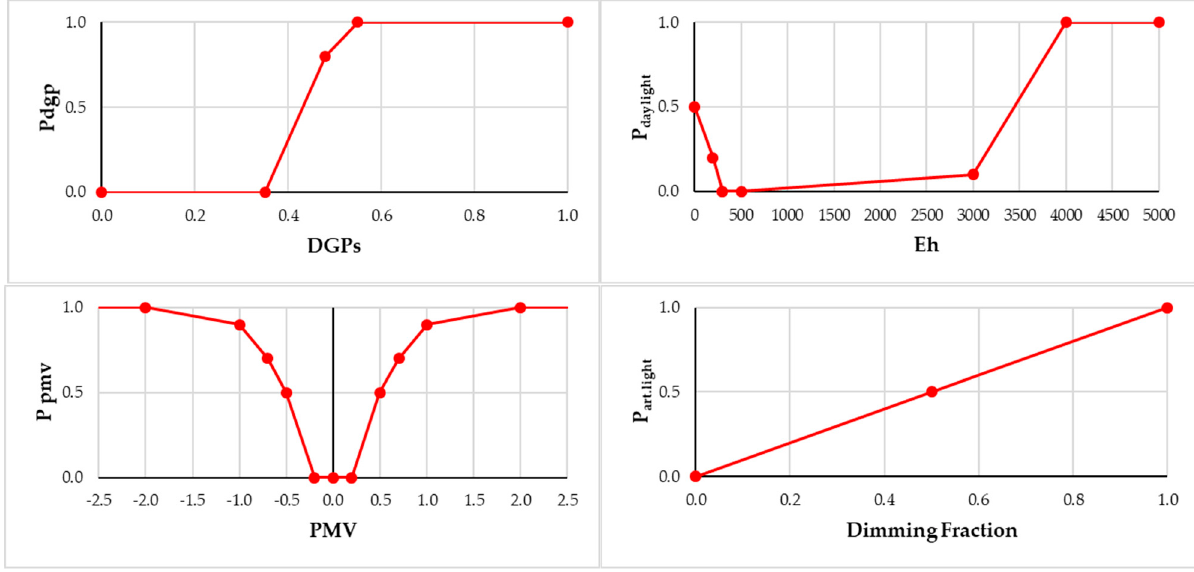
Figure 6. Penalty functions for discomfort glare ( up , left ), daylight ( up , right ), thermal discomfort ( bottom , left ), and electrical lighting ( bottom , right ).